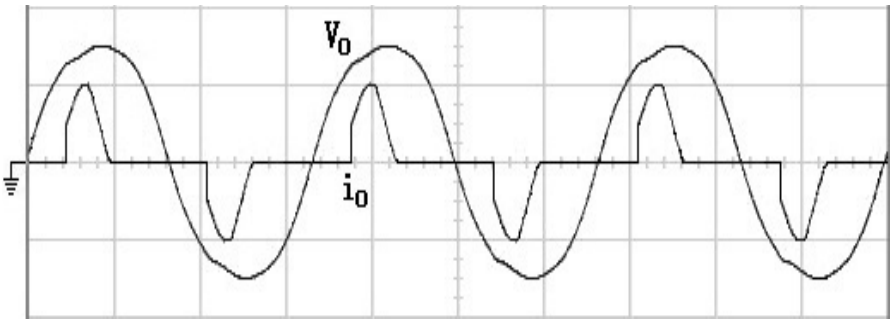
Figure 9. Experimental output waveforms under rectifier load obtained using the proposed